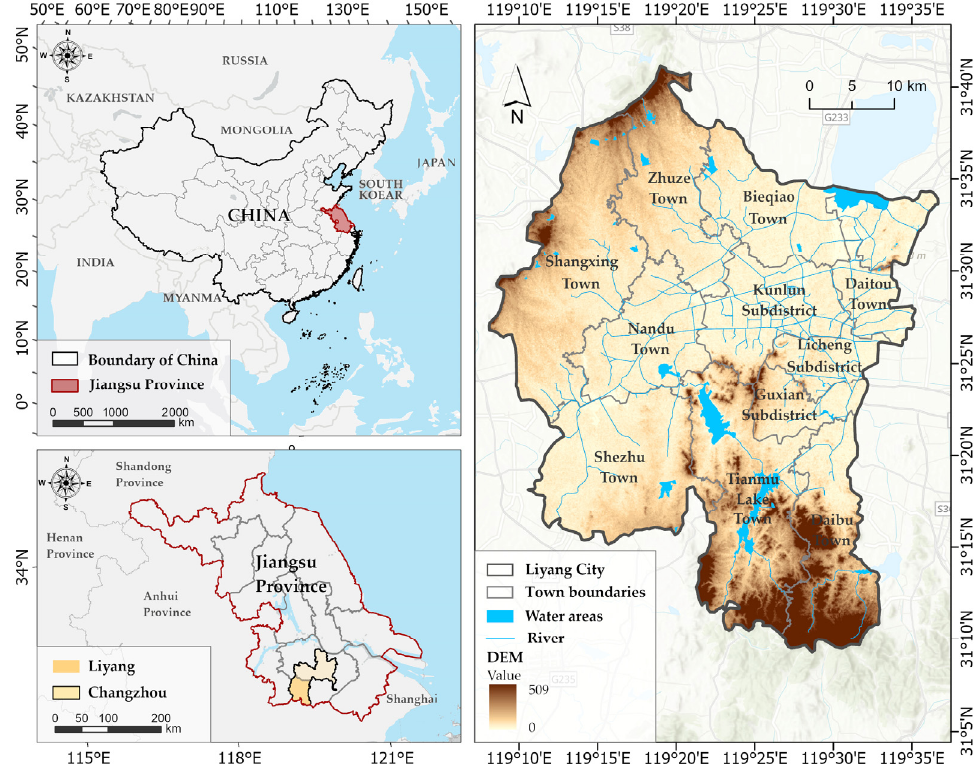
Figure 1. Location and digital elevation map (DEM) of Liyang.